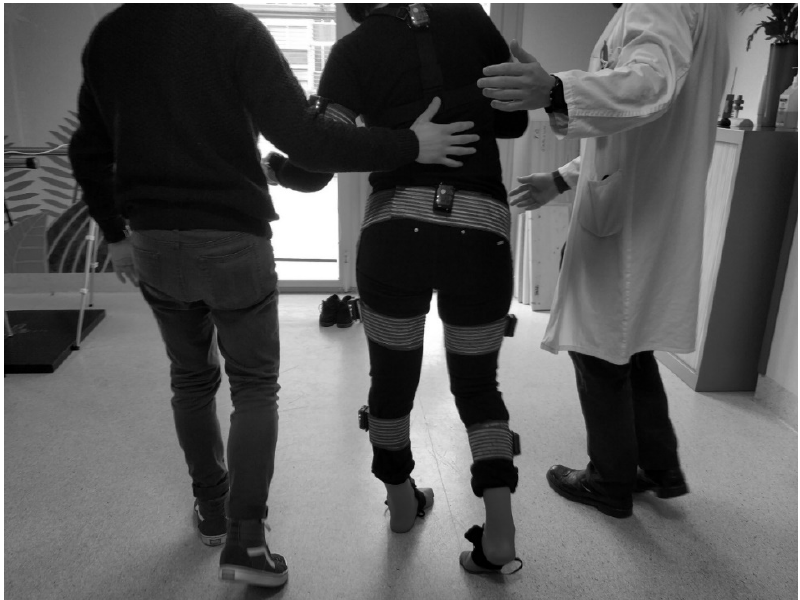
Figure 1. Gait test in hospital. The sensor placement is shown on a patient with spasticity.